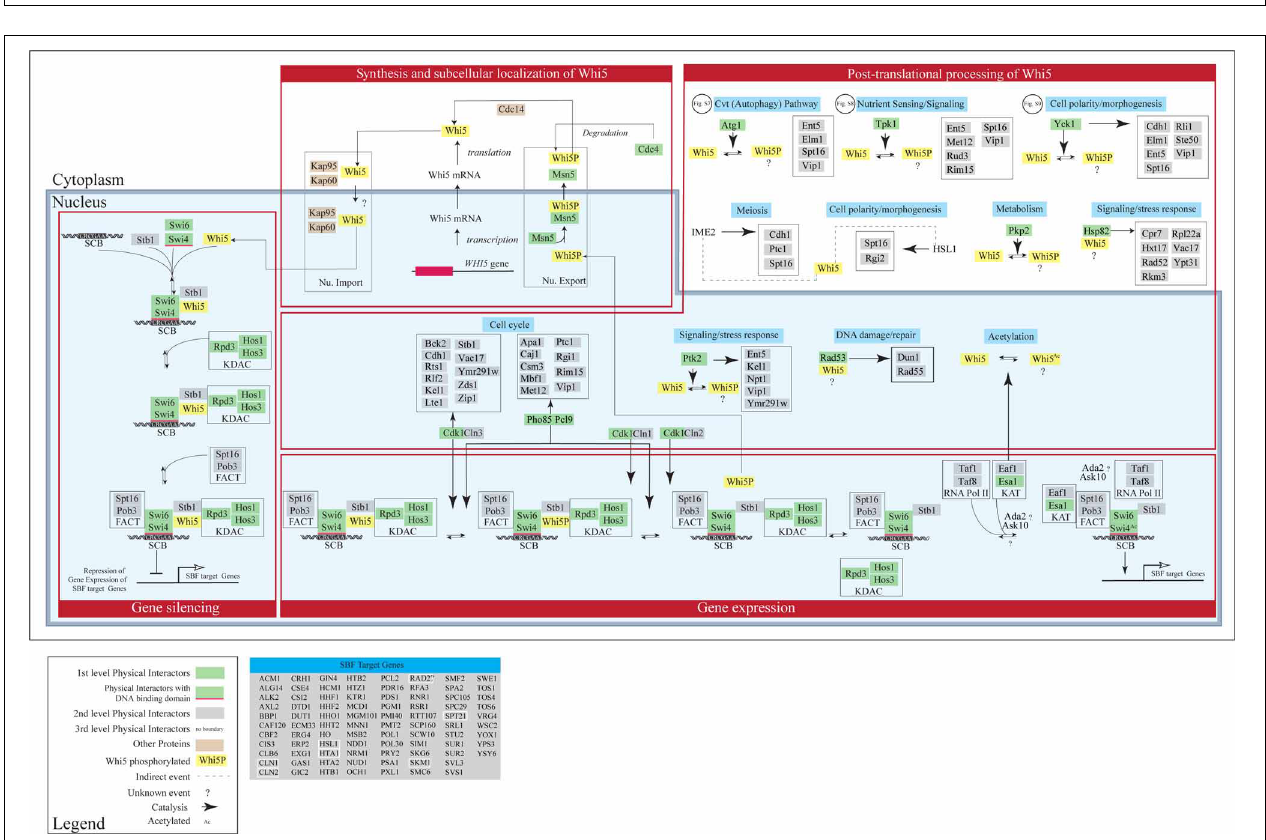
interactors and also shared interaction partners. (C, D) Treemaps of GO term enrichment of p107 (C) and p130 (D) interactors generated by the web service Revigo based on p -value of GO term enrichment of Biological Process. (E) The table contains a short description of the 25 shared interactors.